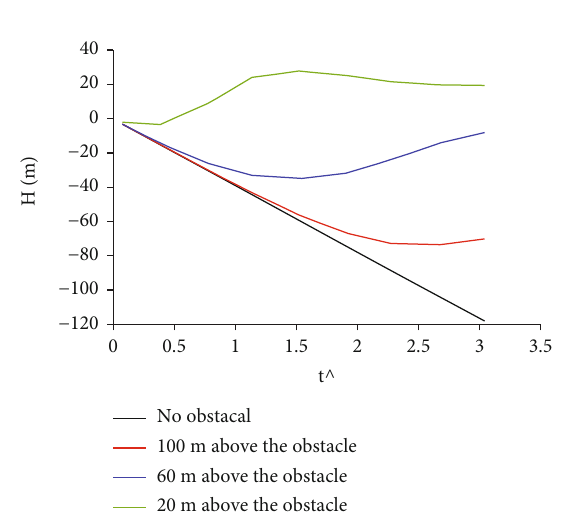
Figure 19: Variation of wake vortex height.